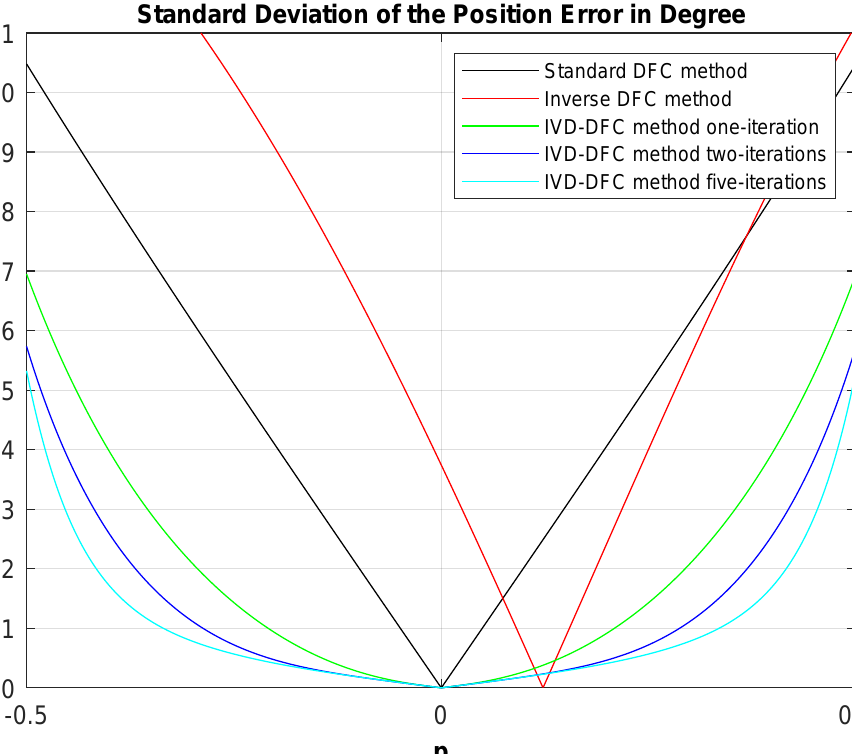
Figure 10. Same as in Figure 5. In this case ˆ b is 10% bigger than b .